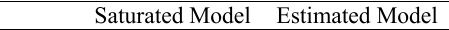
Composite Reliability Test Results Test Results for the Goodness of Fit Model